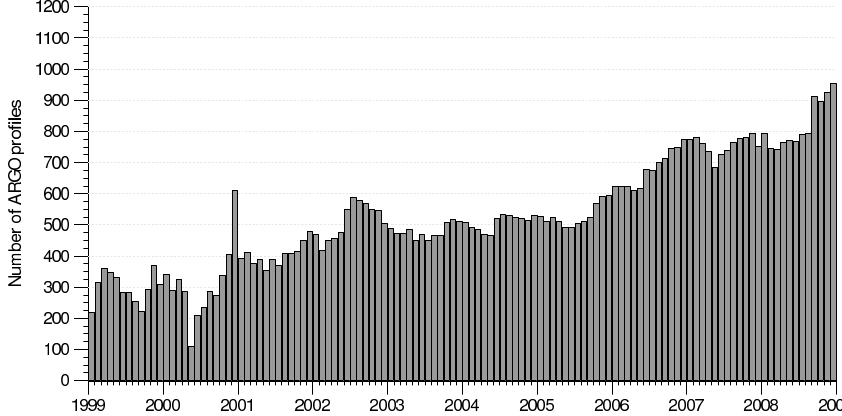
Fig. 3. The temporal distribution of the available Argo data between January 1999 and December 2008.